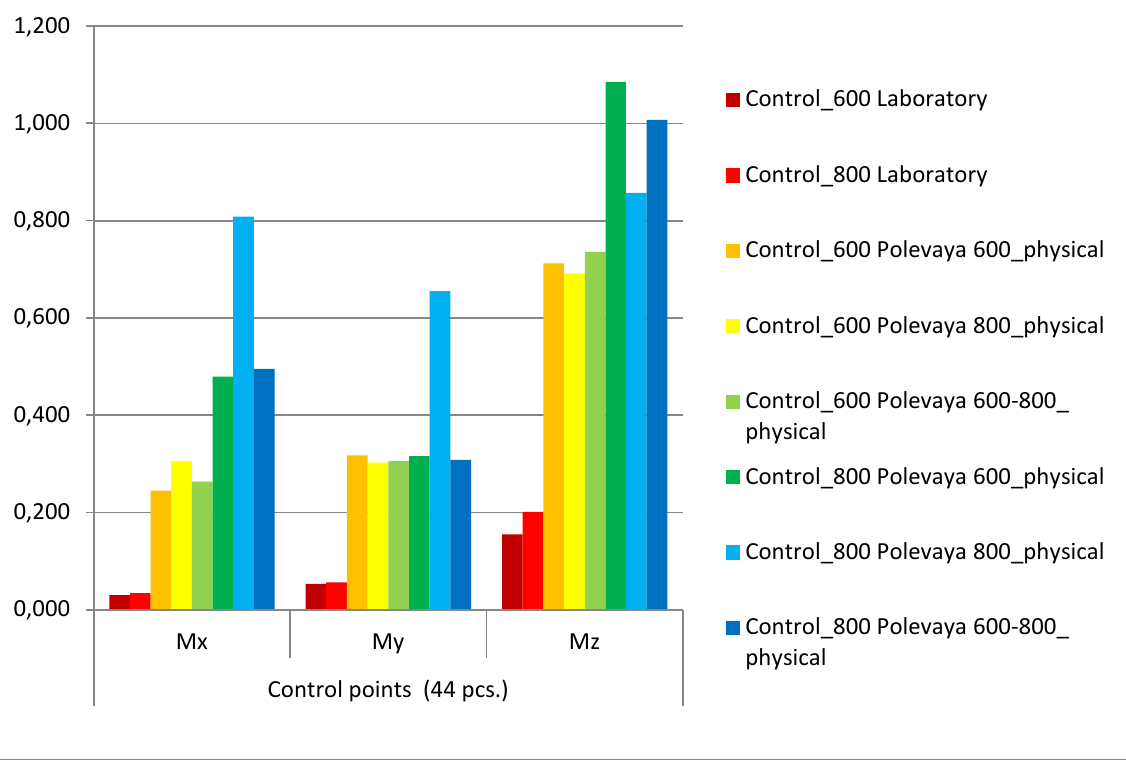
Figure 5. Estimation of accuracy of the triangulation on the basis of results of field calibration. PHOTOMOD (formula physical